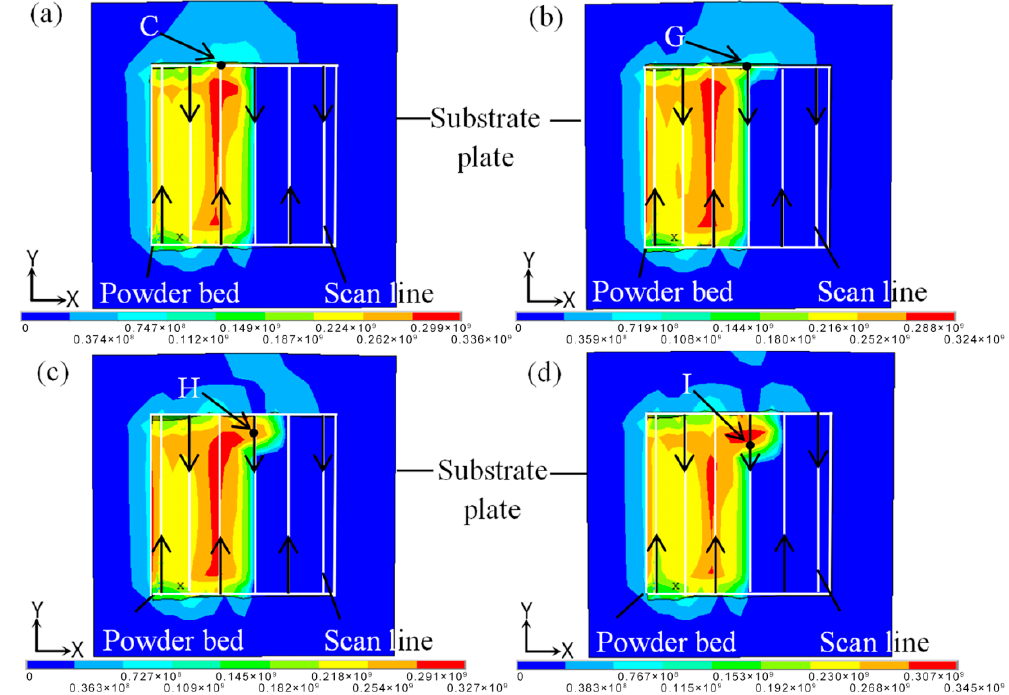
Figure 7. The stress distribution fields near the turning of scan direction. ( a ) Point C; ( b ) Point G; ( c ) Point H; ( d ) Point I.